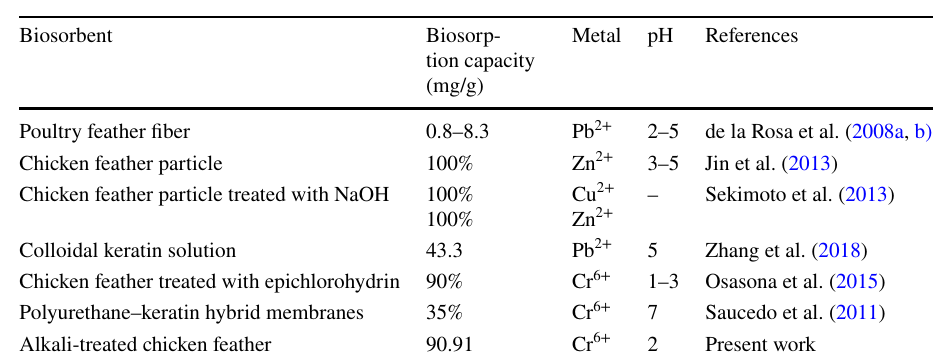
Table 6 Biosorption of Cr(VI) ions by different